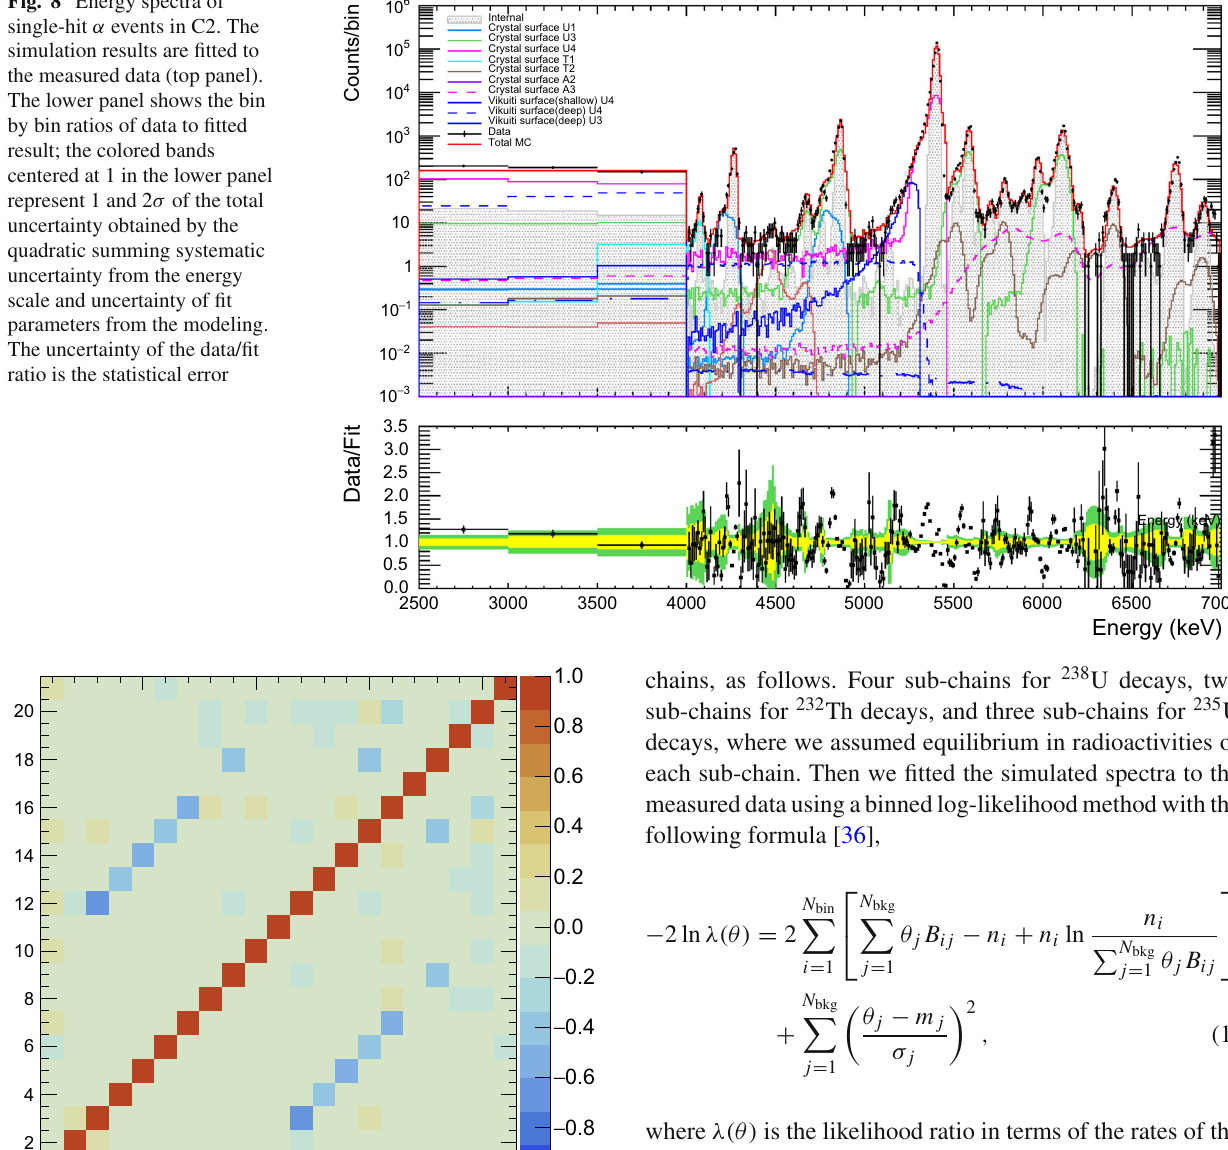
Fig. 9 Correlation matrix among fitted activities in C2